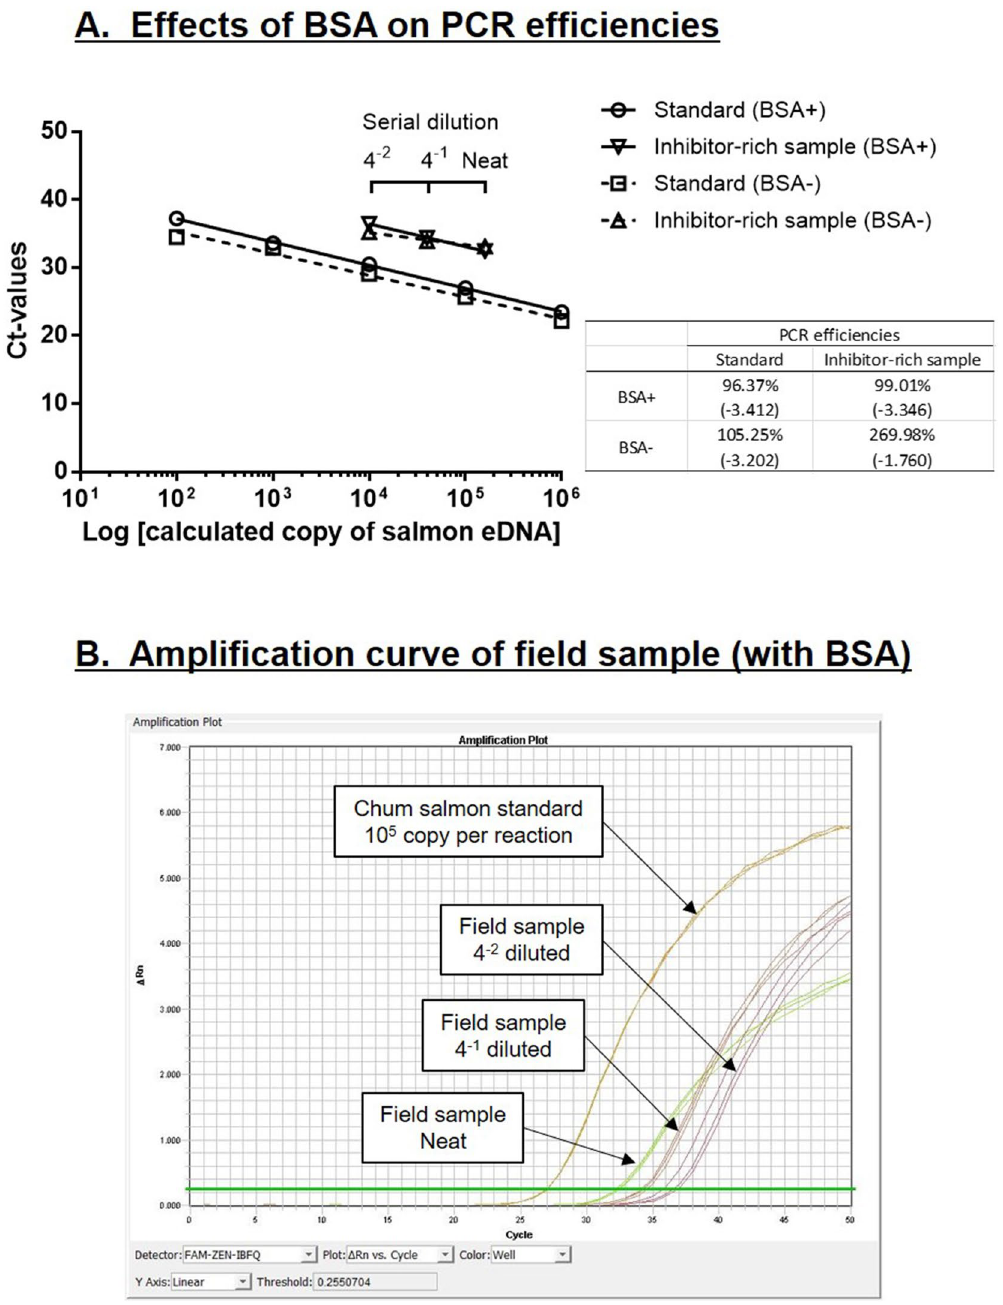
Figure 5. Comparison of PCR robustness between ( A ) ABI Environmental Master Mix 2.0 and ( B ) Takara Probe qPCR Mix on PCR inhibitor tolerance. The real-time PCR was performed with a field sample known to contain high level of PCR inhibitors, and each reaction was spiked with a fixed amount of chum salmon eDNA to monitor the amplification profile. The field sample was serially diluted to reduce the inhibitor influence. PCR efficiency is considered to be compromised when the amplification curve shifts to right or when no amplification is